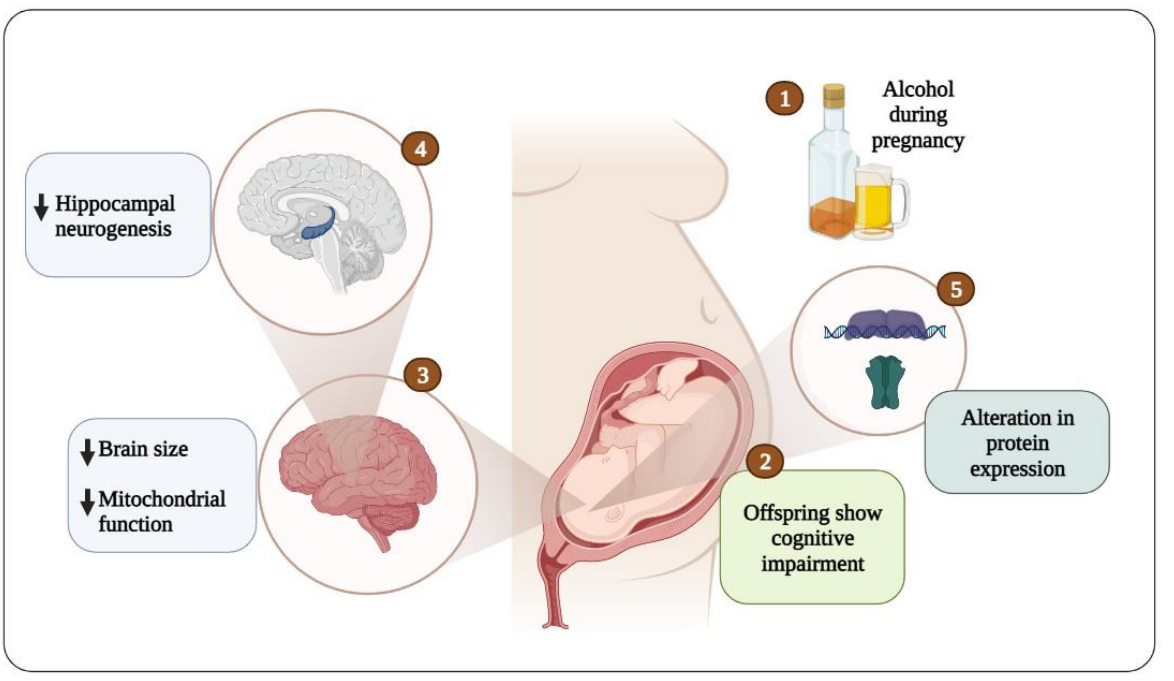
Figure 2. Conceptual diagram of the onset of cognitive impairment due to embryonic alcohol expo- sure.